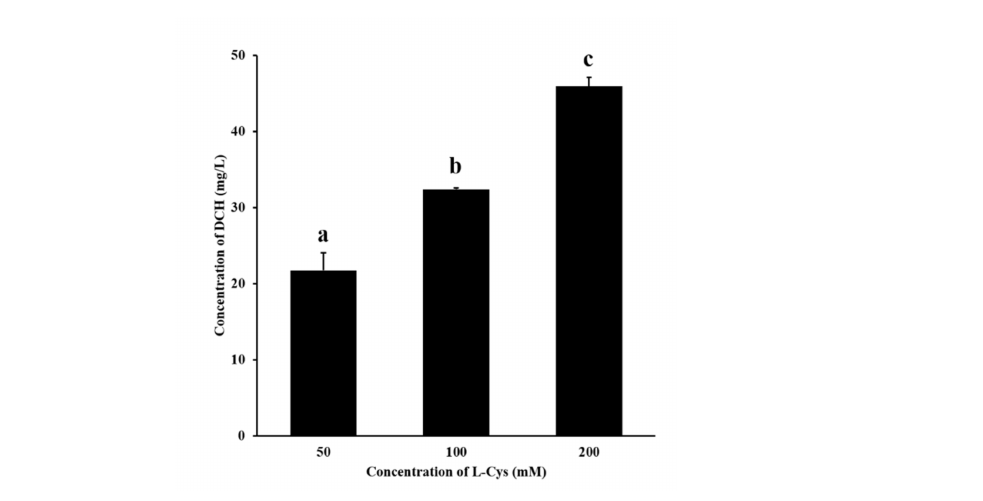
Figure 3. Effect of different concentrations of L-cys on the production of DCH. Different letters indicate significant differences, p < 0.05.